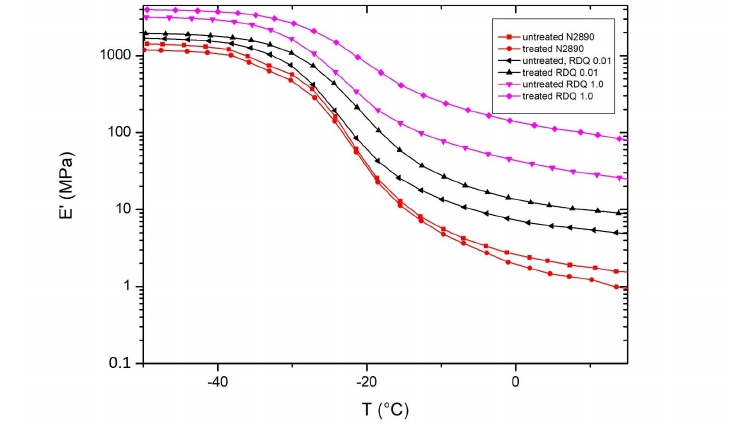
Figure 10. A development of storage modulus of CNT/NBR nanocomposites as a function of relative dispersion quality for untreated and treated